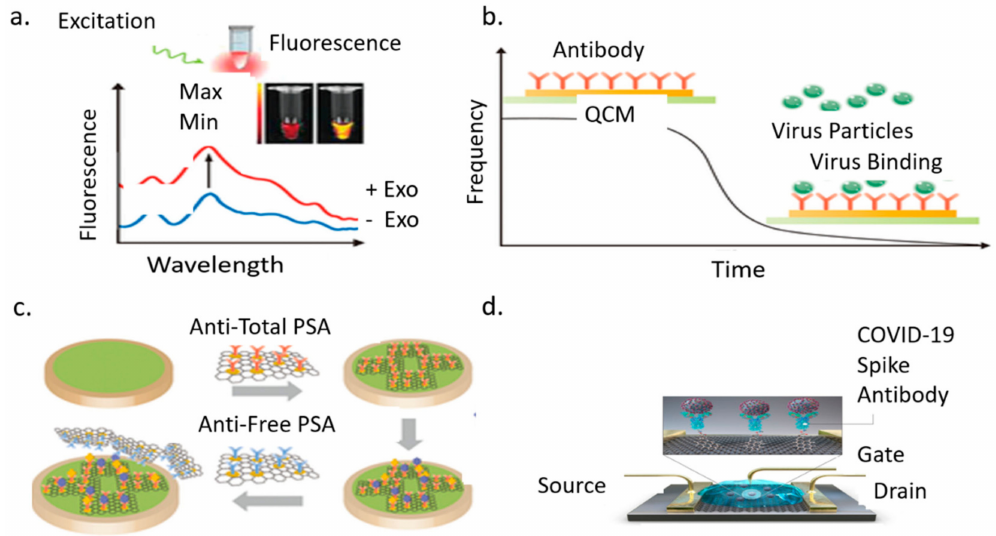
Figure 8. Types of biomarker sensors: ( a ). Optical biosensor; ( b ). Piezoelectric biosensor; ( c ). Electrochemical biosensor, ( d ). Graphene field-effect